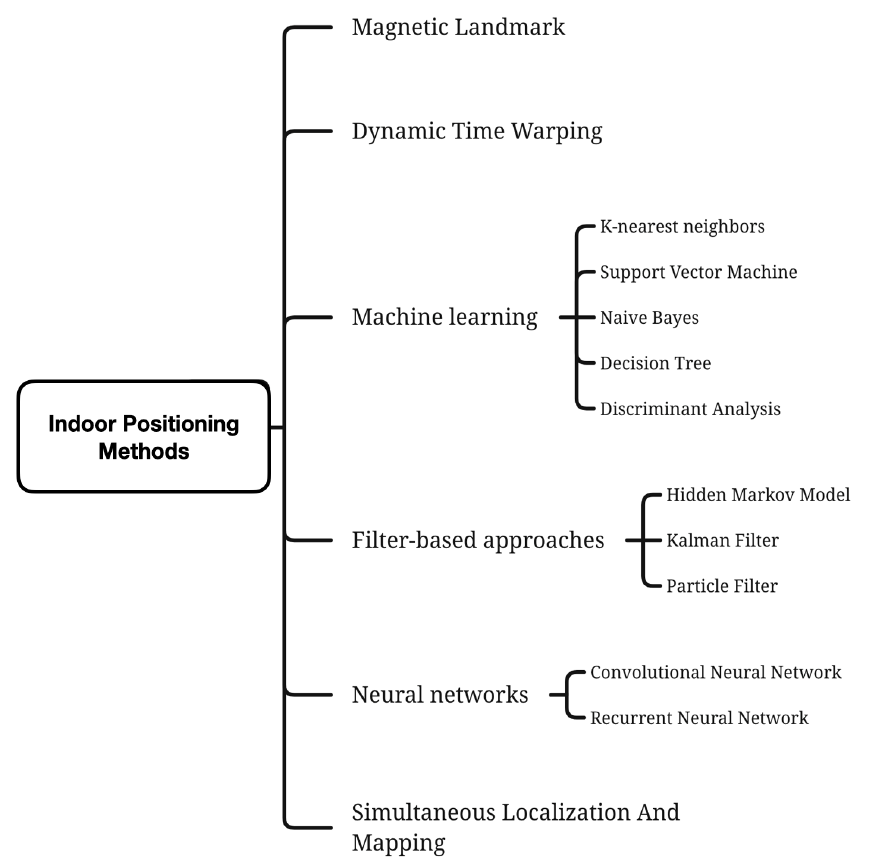
Figure 7. Summary of indoor positioning methods based on magnetic fingerprinting.